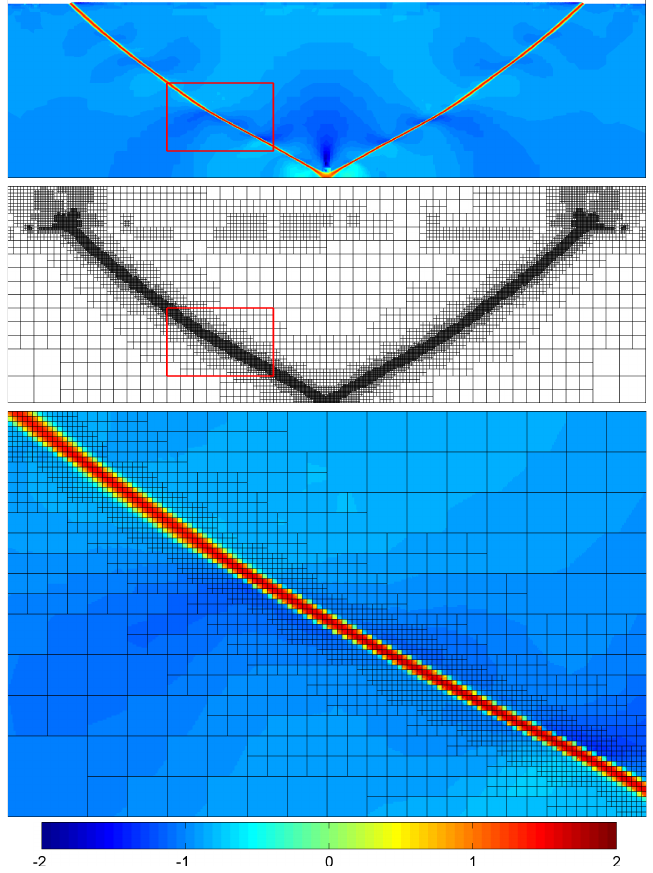
Figure 22. Compression model with φ = 0 ◦ after 1.33% strain; top : log ( ˙ ε II ) plot; middle : numerical grid; bottom : zoom as marked by red rectangles.